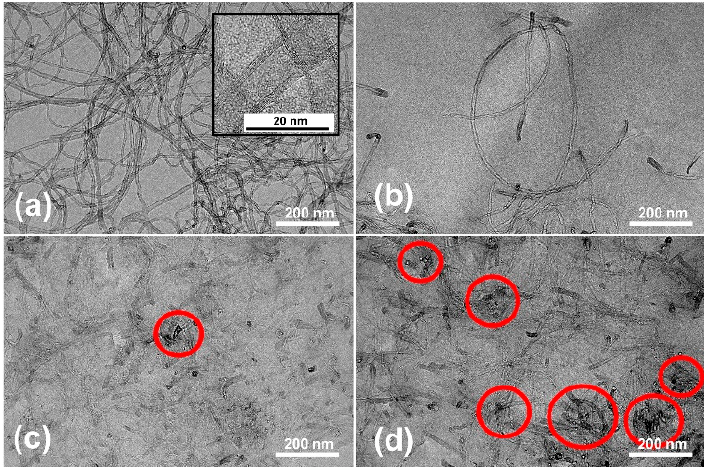
Figure 6. Transmission electron micrographs of ( a ) pure multiwalled carbon nanotubes (MWCNTs) and MWCNT reinforced V-fa/ECO composites at MWCNT contents of ( b ) 0.1 wt%, ( c ) 0.3 wt%, and ( d ) 0.5 wt%.